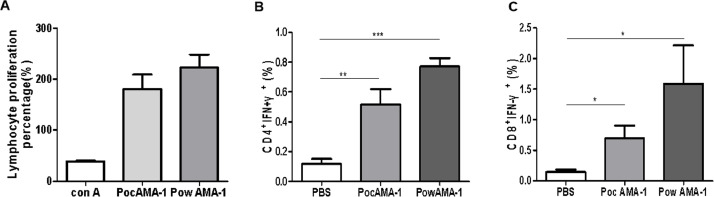
Cellular immune responses of the mice to rPoAMA-1. (A) Lymphocyte proliferation in rPoAMA-1-immunized BALB/c mice and concanavalin A (Con A) as positive control. (B)(C) Measurement of CD4+ INF-γ+ and CD8+ INF-γ+levels in mice by flow cytometry. T cells after stimulation with rPoAMA-1; values represent the percentage of either CD4+ or CD8+ T cells positive for the individual cytokine. A t-test was used to determine differences in production of IFN-γ in response to a stimulus with corresponding antigens. Significant differences between groups are denoted on the graph: * P < 0.05, **P < 0.01, *** P <0.001. Nonsignificant (ns) differences are indicated (P > 0.05).